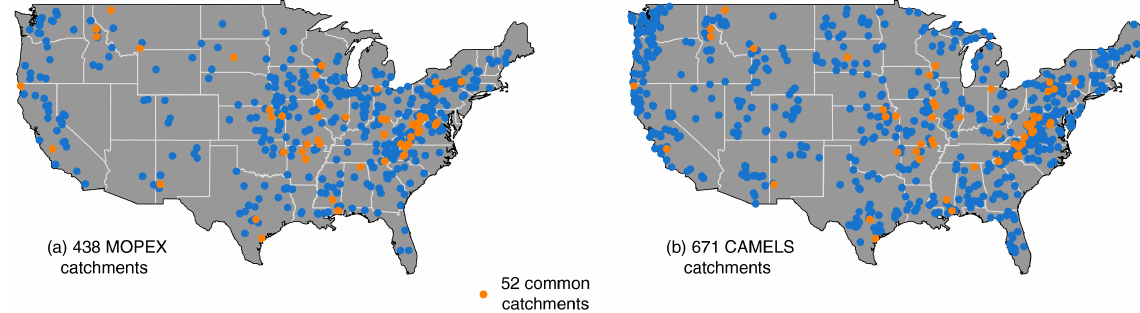
Figure 8. A comparison of the spatial distribution of the catchments from (a) the MOPEX data set and (b) the CAMELS data set. Table 7. Main differences and similarities between MOPEX and CAMELS. MOPEX CAMELS 671 catchments, with a relatively even distribu- Number of catchments and spatial distribution 438 catchments, principally from the east- tion over the CONUS ern half of the CONUS and with an under- representation of the Rocky Mountains Number of catchments common to MOPEX and